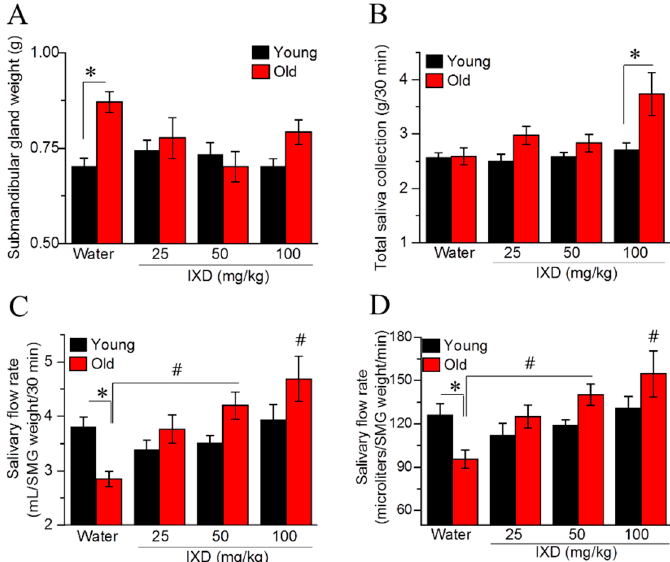
Figure 1. Ixeris dentate (IXD) improves aging-induced salivary dysfunction. Water or IXD extract was given orally to young and aging rats for eight weeks. Saliva and the submandibular glands were collected on the sacrificing day. ( A ) Weight of submandibular glands (g), * p < 0.05 vs. young control rats; ( B ) Total saliva collected over 30 min, * p < 0.05 vs. young IXD 100 mg/kg group; ( C ) Salivary flow rate by submandibular gland weight (mL/SMG weight/30 min); ( D ) Salivary flow rate by submandibular gland weight per minute (µL/SMG weight/min). * p < 0.05 vs. young control rats, # p < 0.05 vs. old control rats.